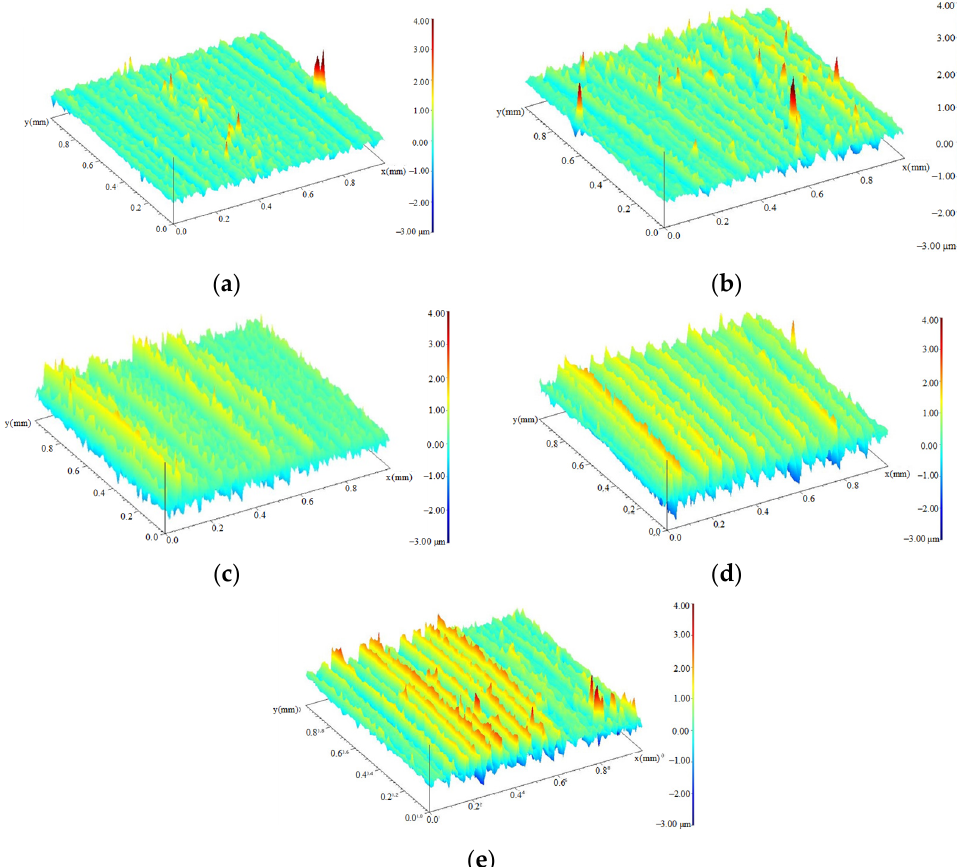
Figure 5. Surface topography of ultrasonic-impacted specimens during fatigue evolution. ( a ) 0 cycles; ( b ) 1.68 × 10 4 cycles; ( c ) 1.68 × 10 5 cycles; ( d ) 9.66 × 10 5 cycles; ( e ) 1.68 × 10 6